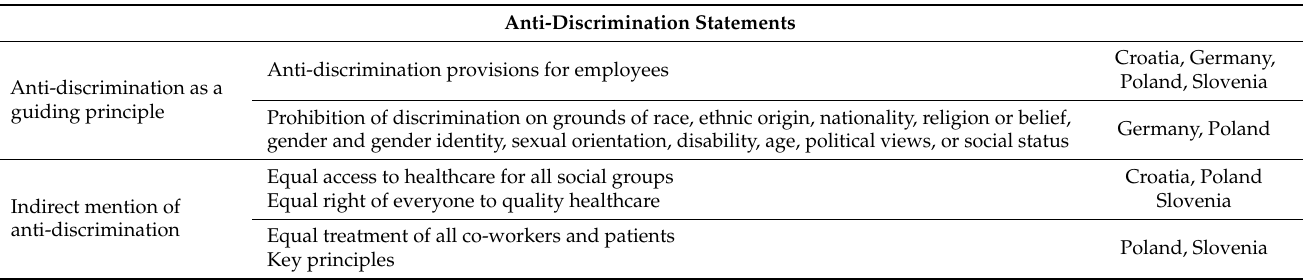
Table 2. Anti-discrimination statements in hospitals internal documents in Croatia, Germany, Poland, and Slovenia. Anti-Discrimination